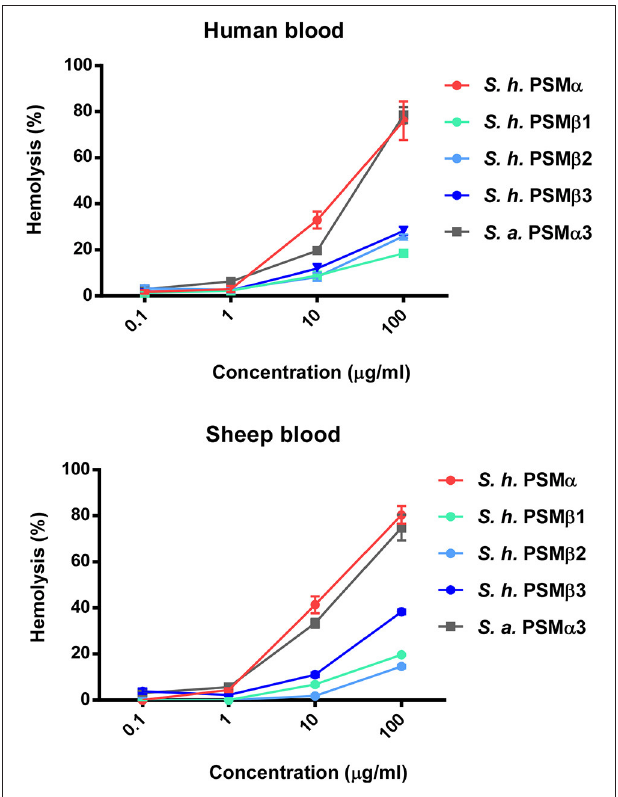
FIGURE 6 | Hemolytic activities of S. haemolyticus PSMs. Hemolytic activities of S. haemolyticus PSMs at different concentrations were measured using incubation with human erythrocytes and compared to that achieved with equal amounts of PSM α 3 of S. aureus . Activities are compared as percentage compared to a control with total lysis. Data are from assays performed in quadruplicate.